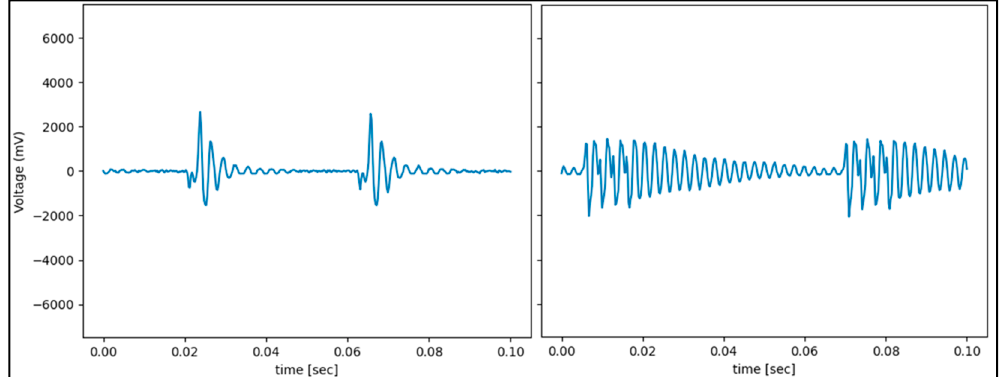
Figure 10. Coagulate Valley Lab ( left ) vs. ConMed ( right ).